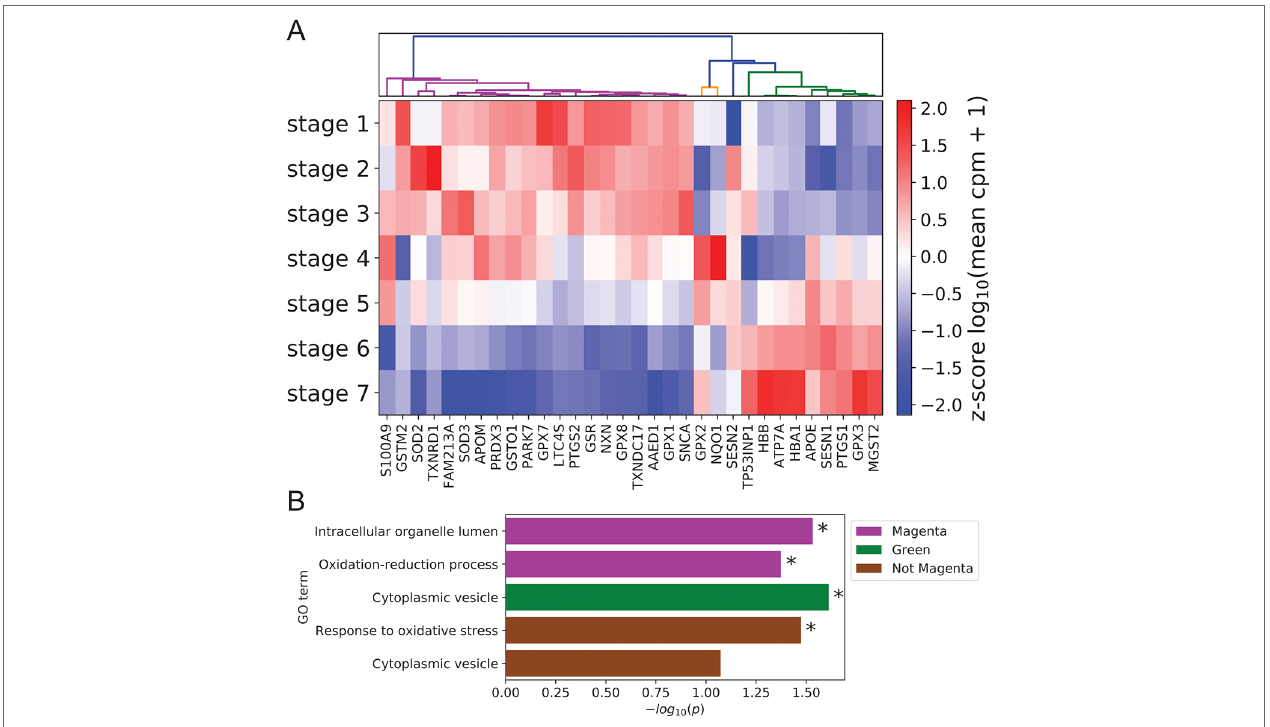
FIGURE 5 | Peak expression of dynamic antioxidant genes is enriched in the BK state. (A) Log-transformed stage-wise mean imputed expression of dynamic antioxidant genes normalized across stages. Columns are organized by hierarchical clustering (Methods). (B) Minus log of unadjusted p values (Methods) for selected GO terms enriched in selected gene sets clustered from (A) . Asterisks indicate significance at 0.05